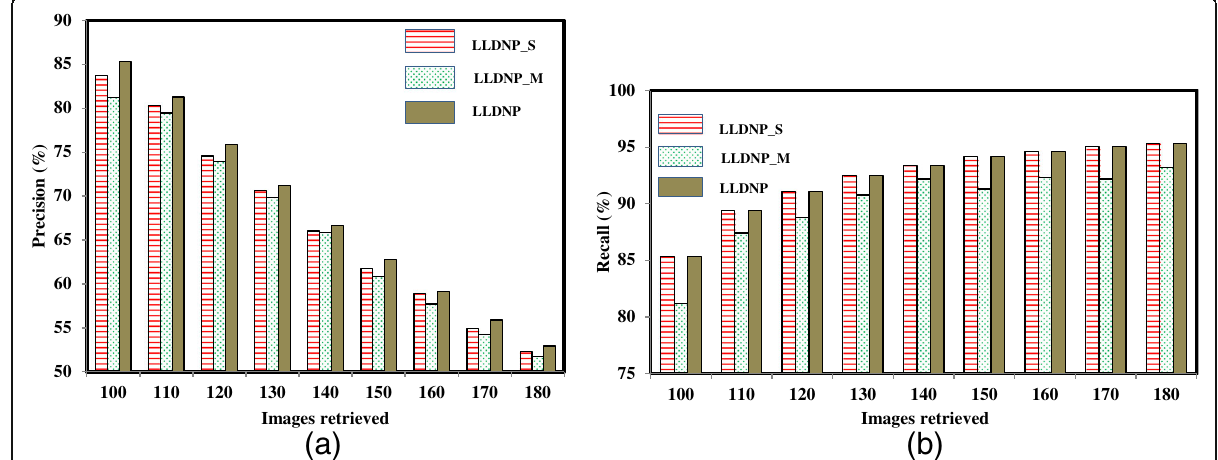
Fig. 18 Comparison of LLDNP_S, LLDNP_M, and LLDNP in terms of a precision and b recall on Virus database. The performance of LLDNP_S is better than LLDNP_M. But LLDNP shows higher performance than LLDNP_S and LLDNP_M in terms of precision and recall on Virus